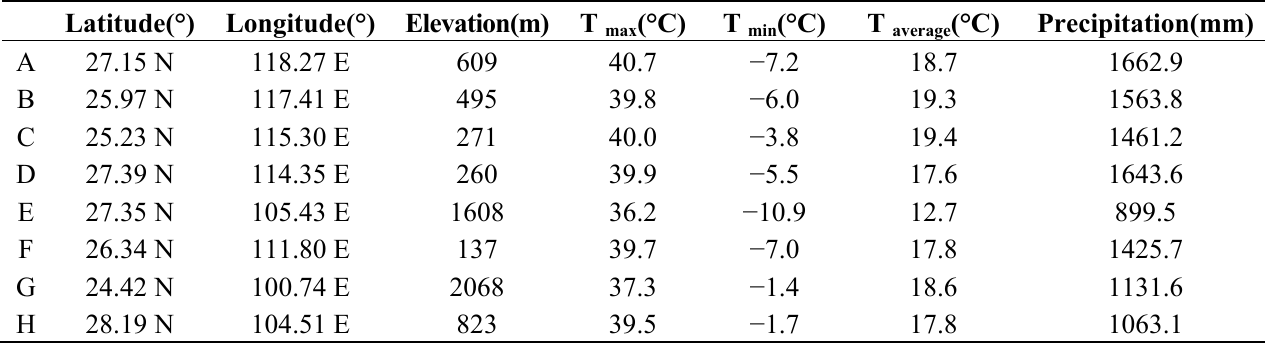
Table 1. Climate and geographic habitats of Litsea cubeba .